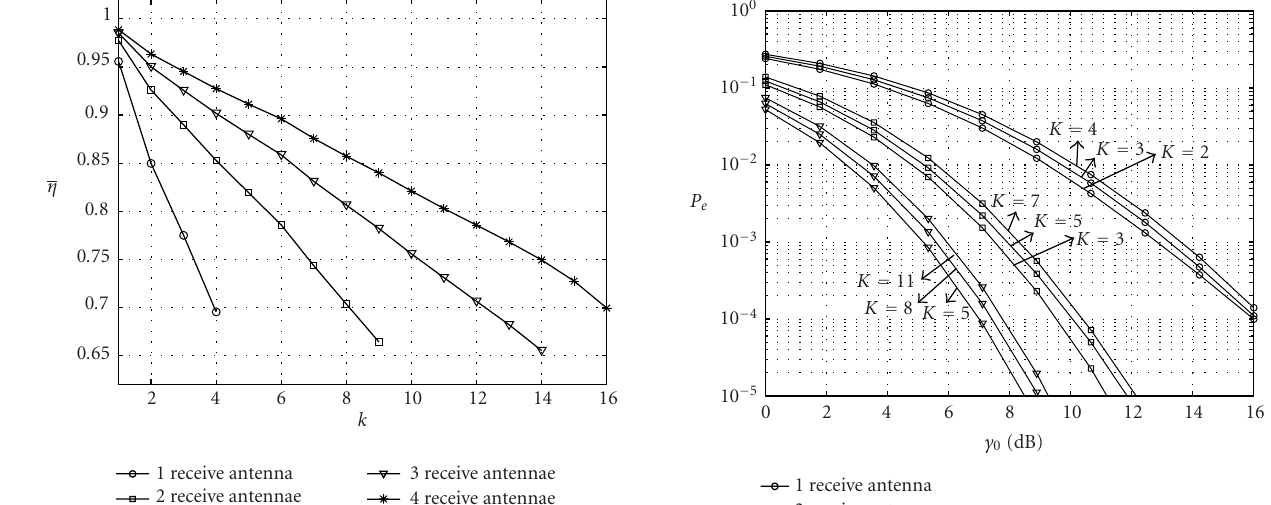
reception (observe that the maximum number of user K